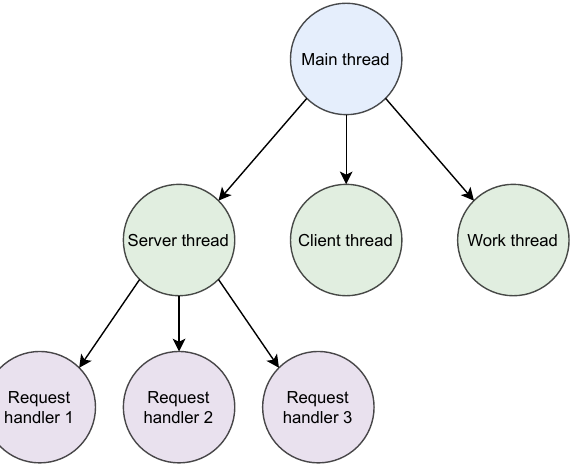
Figure 2. The general process structure of Áika’s components. Each process is organized in a hierarchy of threads, where a main thread starts several child threads. Child threads are restarted by the main thread if they fail. Servers spawn multiple request handler threads to enable requests from multiple sources to be handled